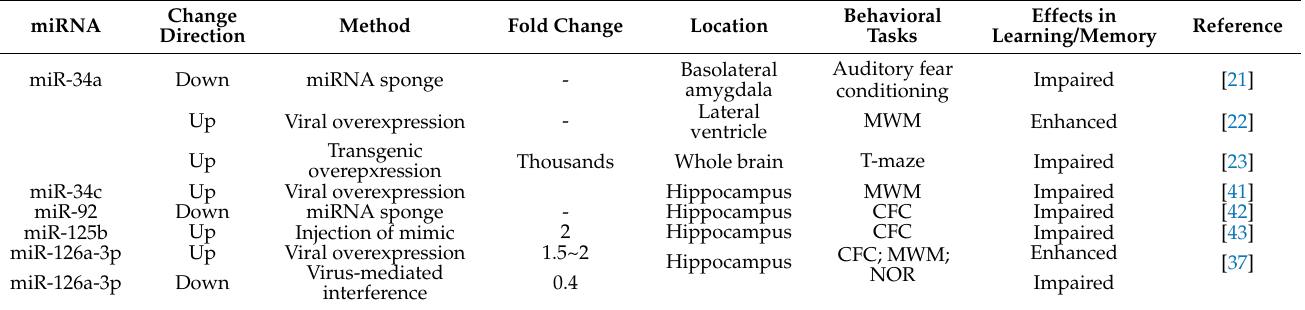
Table 1. Manipulation of miRNA levels in regulating learning and memory in wild-type